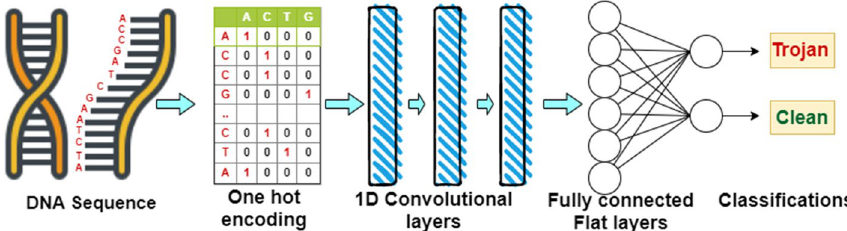
Figure 4. 1-Dimensional Convolutional Neural Network (1D CNN): Architecture. (The image is drawn using draw.io).